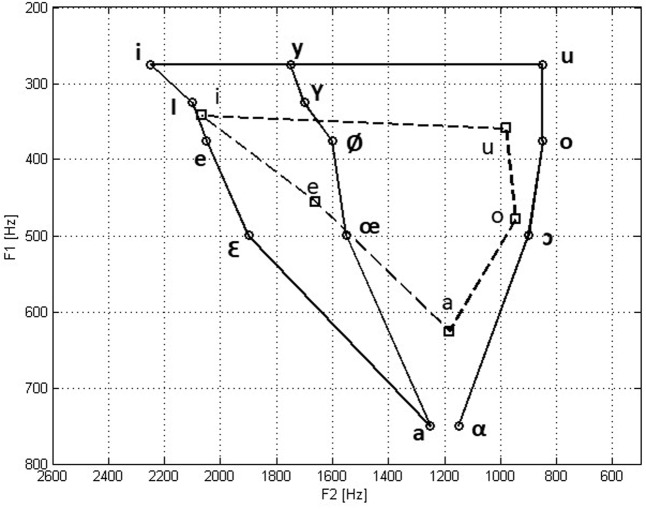
An illustration of the vowel space between the first and second formants for German (continues line) and Hebrew (dashed line).